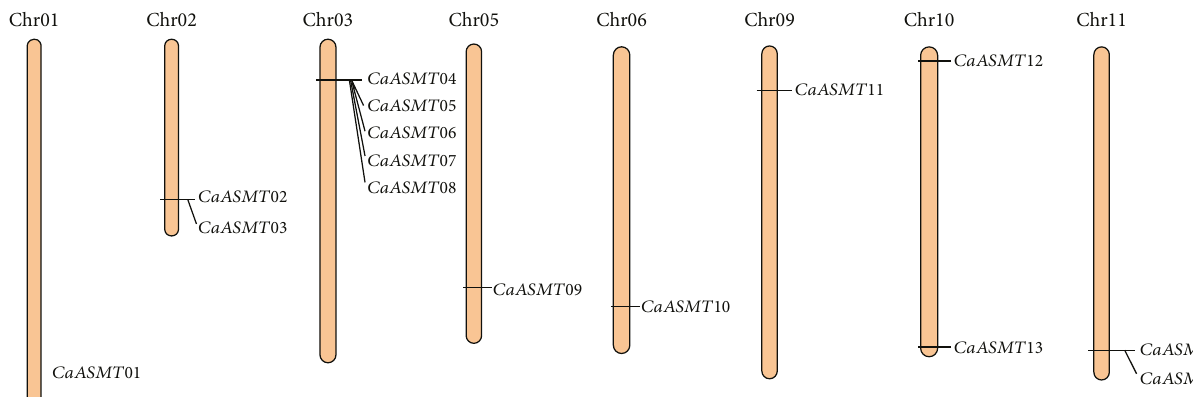
Figure 2: Chromosomal location and tandem duplication of CaASMT genes. Black boxes showed the tandem duplication genes on chromosomes. The chromosome numbers are indicated at the top of